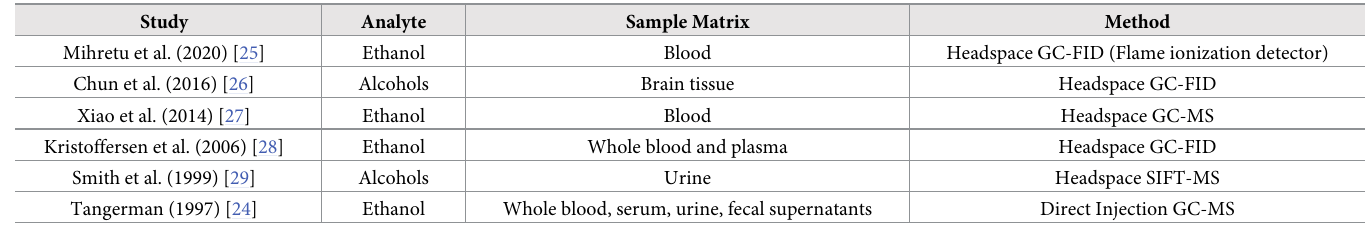
Table 2. Literature survey of gc methods for the quantitation of ethanol in biological matrices.